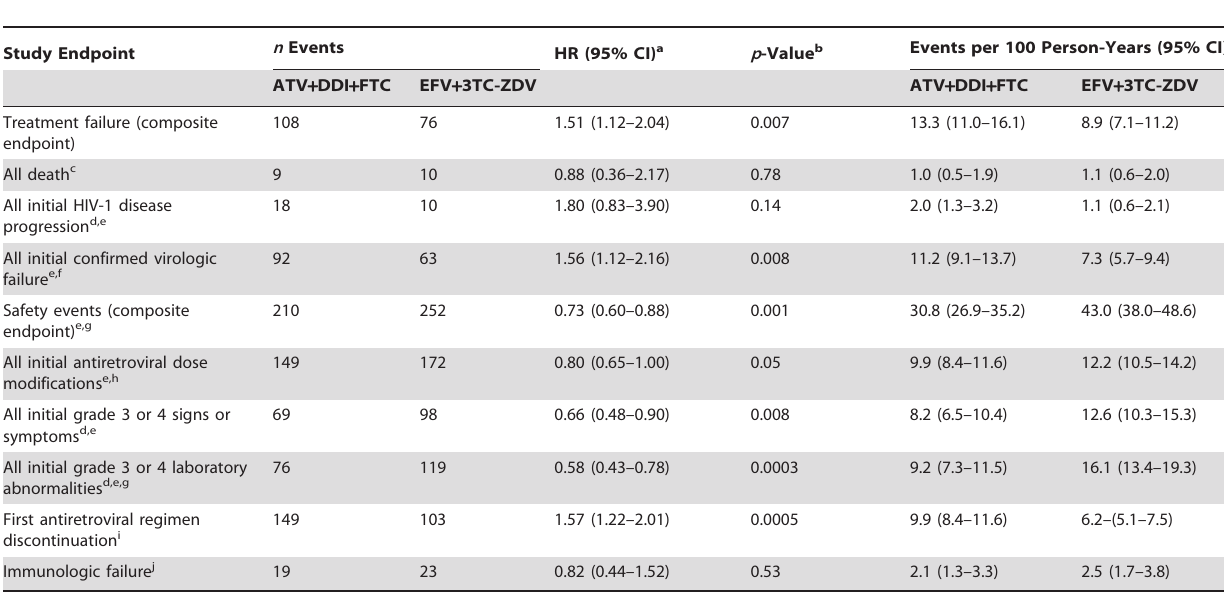
(Table 1). The estimated cumulative probability of any dose modification of the assigned antiretroviral regimen at 48 wk was 20.7% (CI 17.5%–24.4%) compared to 25.7% (CI 22.1%–29.7%), respectively. Excluding hyperbilirubinemia, there were fewer (Table 2). Treatment failure relative risk did not change significantly over time ( p = 0.9) (Figure 2B). There were no severe or potentially life-threatening laboratory abnormalities in Table 1. Primary and secondary time-to-event outcomes for the comparison of atazanavir plus didanosine-EC and emtricitabine